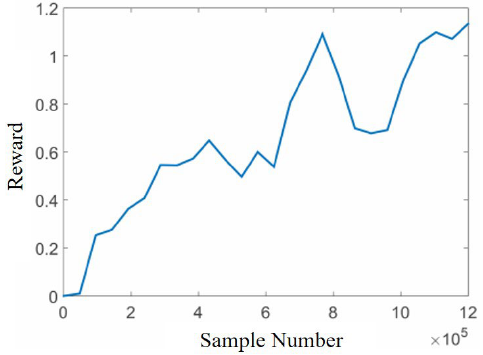
Figure 7. Training reward.